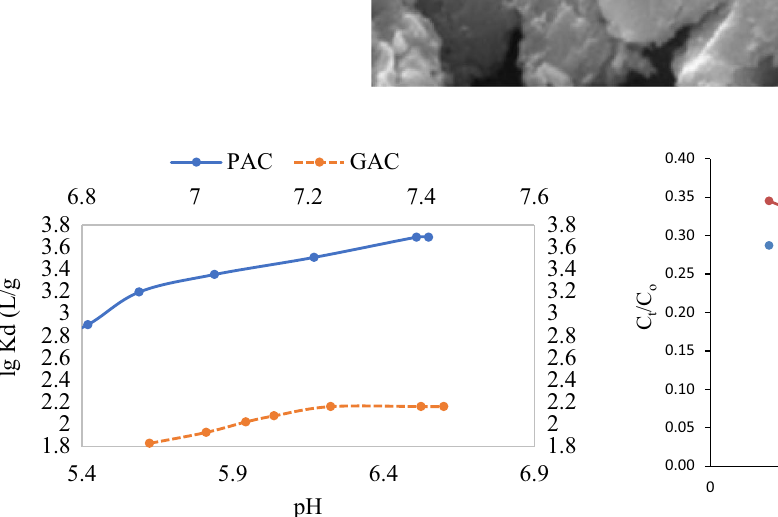
Fig. 2 SEM micrographs of activated carbons a without treatment and b treated with mercury ions,